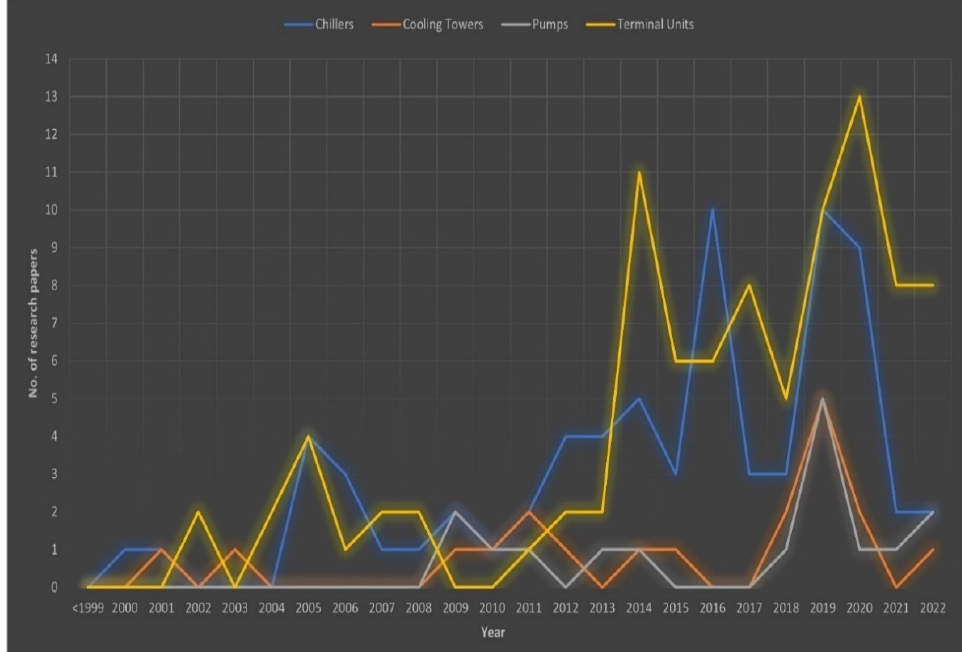
Figure 6. Research trends.